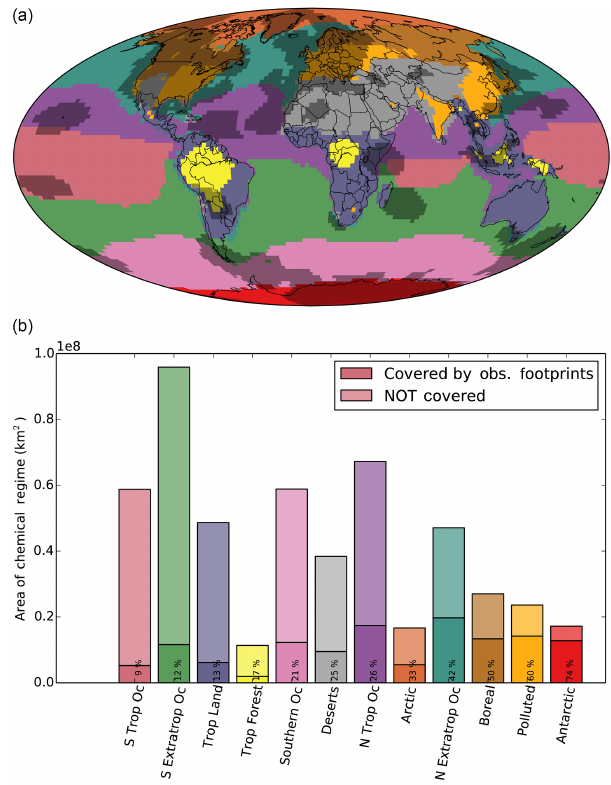
Figure 4. Chemical regimes defined by a cluster analysis of GEOS- Chem tracers. Panel (a) shows a map of the chemical regimes, with shading indicating areas covered by the footprints of existing ozone sites. In (b) , the area of each chemical regime from (a) that is cov- ered (dark) or is not covered (light) by the footprints of ozone ob- serving sites is shown. The bars are ordered by increasing fractional coverage shown above the regime